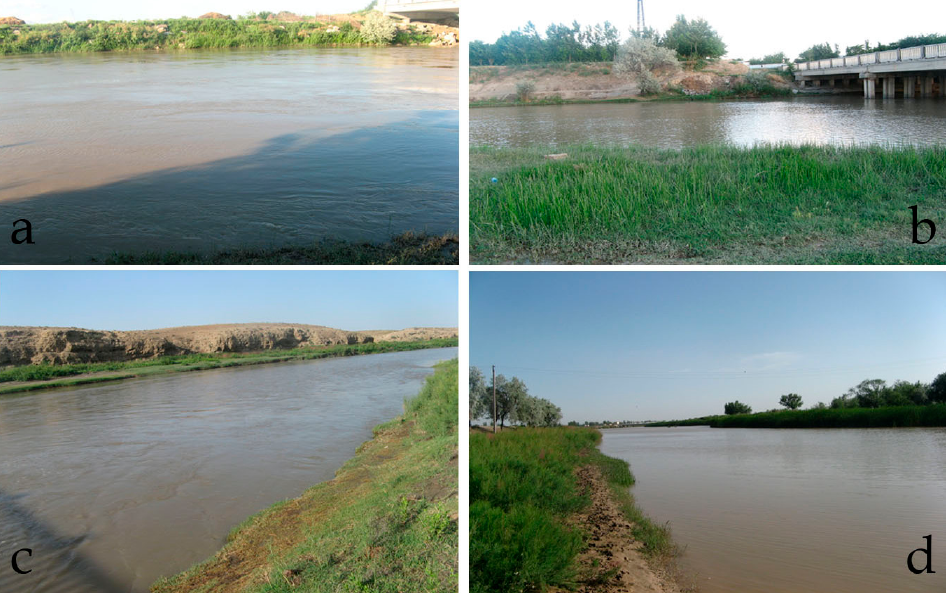
Figure 2. Sampling sites in the Zarafshan River: Khatyrchi ( a ), Navoi ( b ), Ghidzhuvan ( c ), Bukhara ( d ).